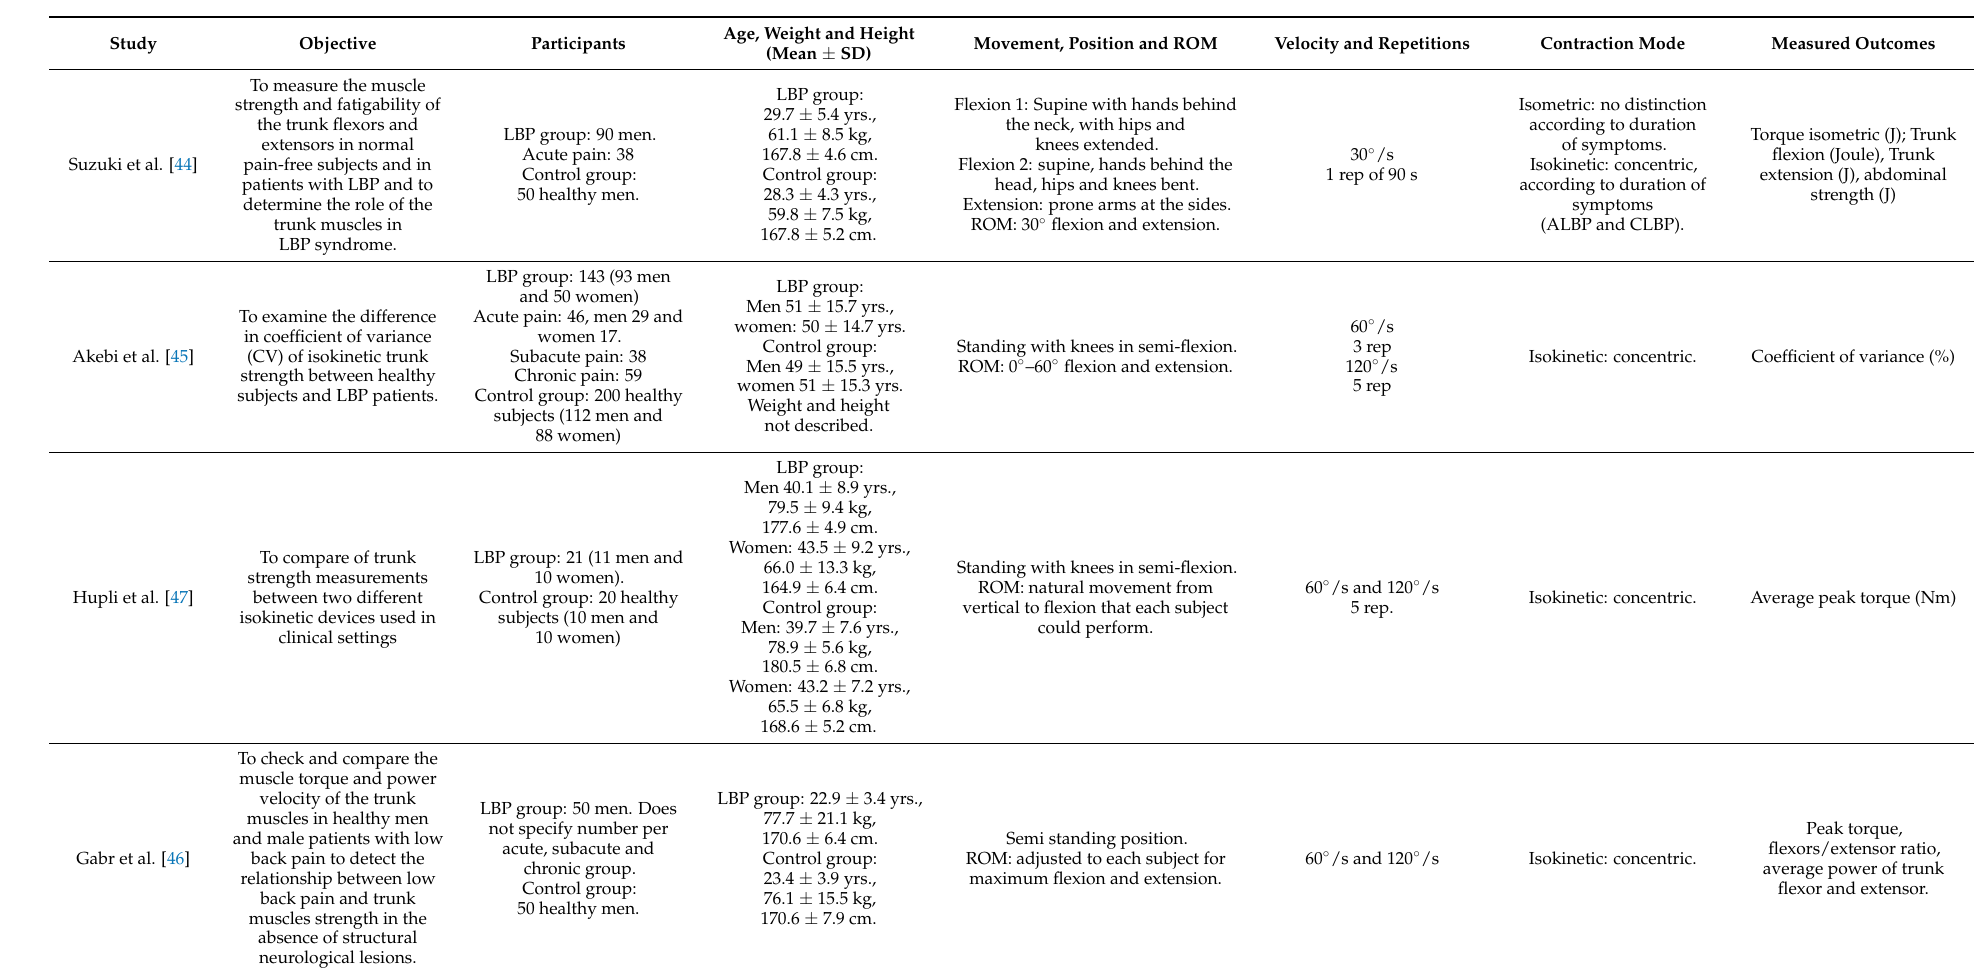
Table 1. Characteristics of individual